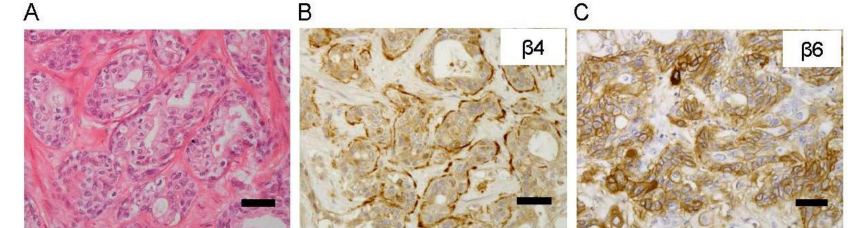
Figure 1. Expressions of β 4 and β 6 integrin in intrahepatic cholangiocarcinoma. Hematoxylin and eosin staining ( A ). The expressions of the β 4 and β 6 integrins are shown in the basal lamina ( B ), cell membranes, and cytoplasm ( C ). Scale bar, 50 µ m. Original magnification, × 200.